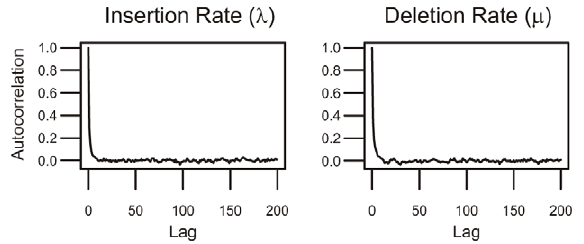
Figure 5. Autocorrelation of rate parameters. Parameters were estimated for the toy network phylogeny shown in Figure 1 using the Gibbs sampler described in Section ‘Estimation of parameters’. The values are averaged across three runs containing 60,000 iterations each.